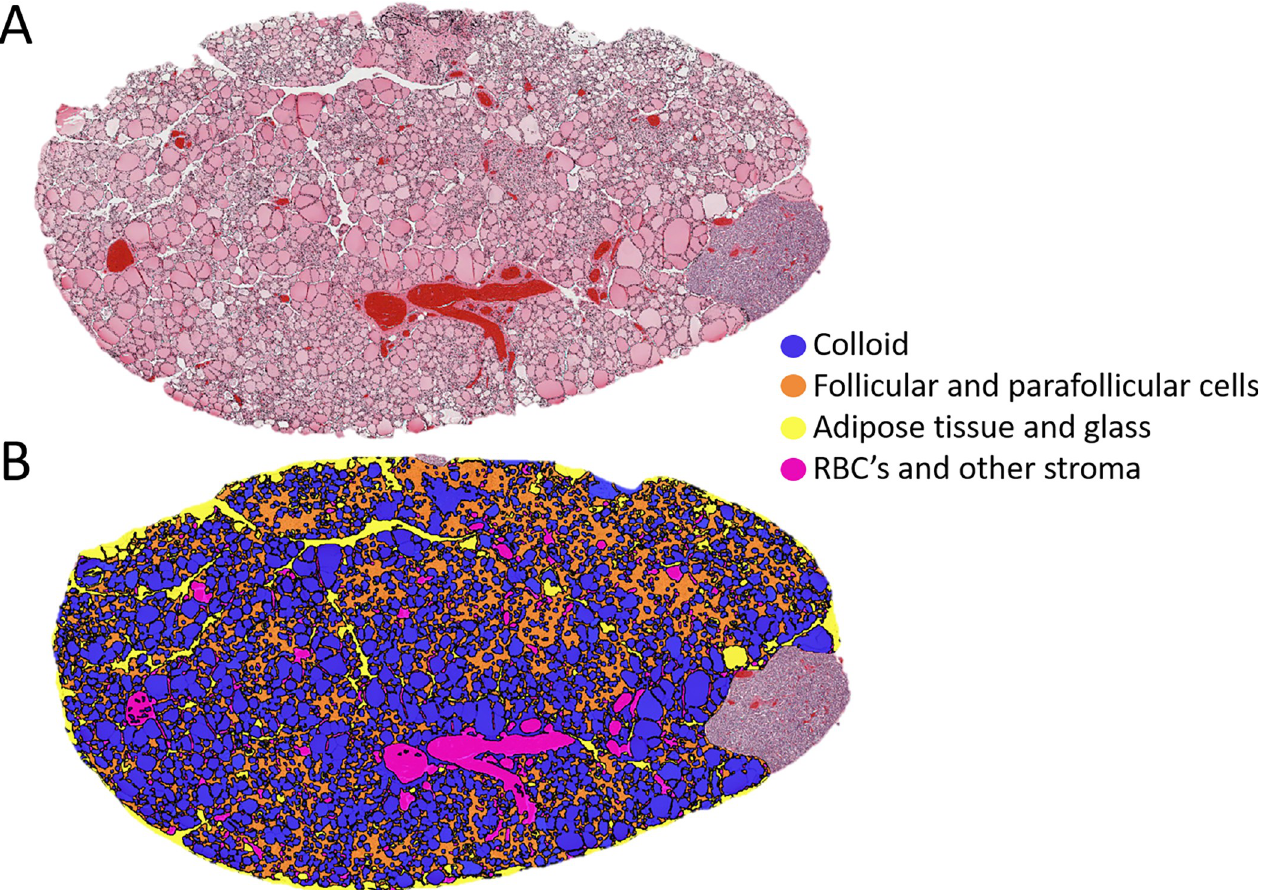
Fig 7. Histology (A) and computerized histomorphometry (B) of thyroid gland tissue from a 13 year old castrated male American Cocker Spaniel with gallbladder mucocele formation. Panel A represents the scanned in image of the original hematoxylin and eosin stained gland. Panel B demonstrates the computer-generated assignment of each tissue architectural feature into one of 4 different categories as